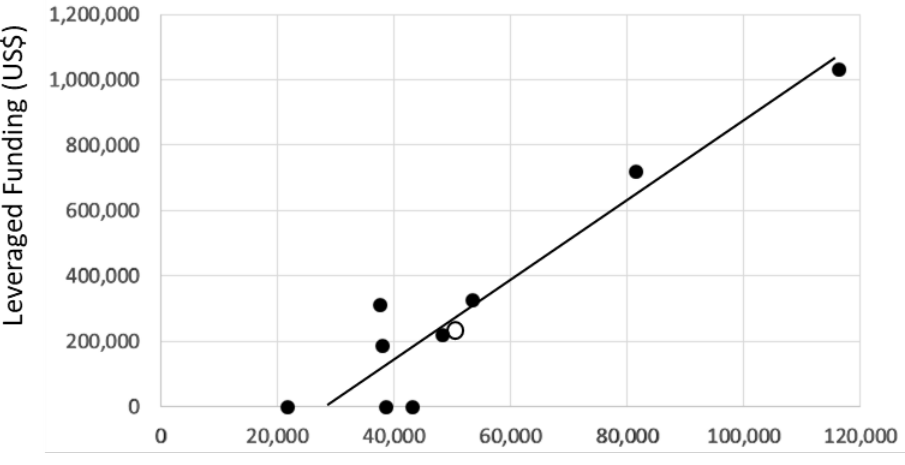
Figure 1. Positive correlation between seed funding ( x -axis) and leveraged external awards ( y -axis) in the first program (solid circles) and the third program (open circle). The best fit regression line is shown, with the x-intercept representing the break-even point for positive leveraging.